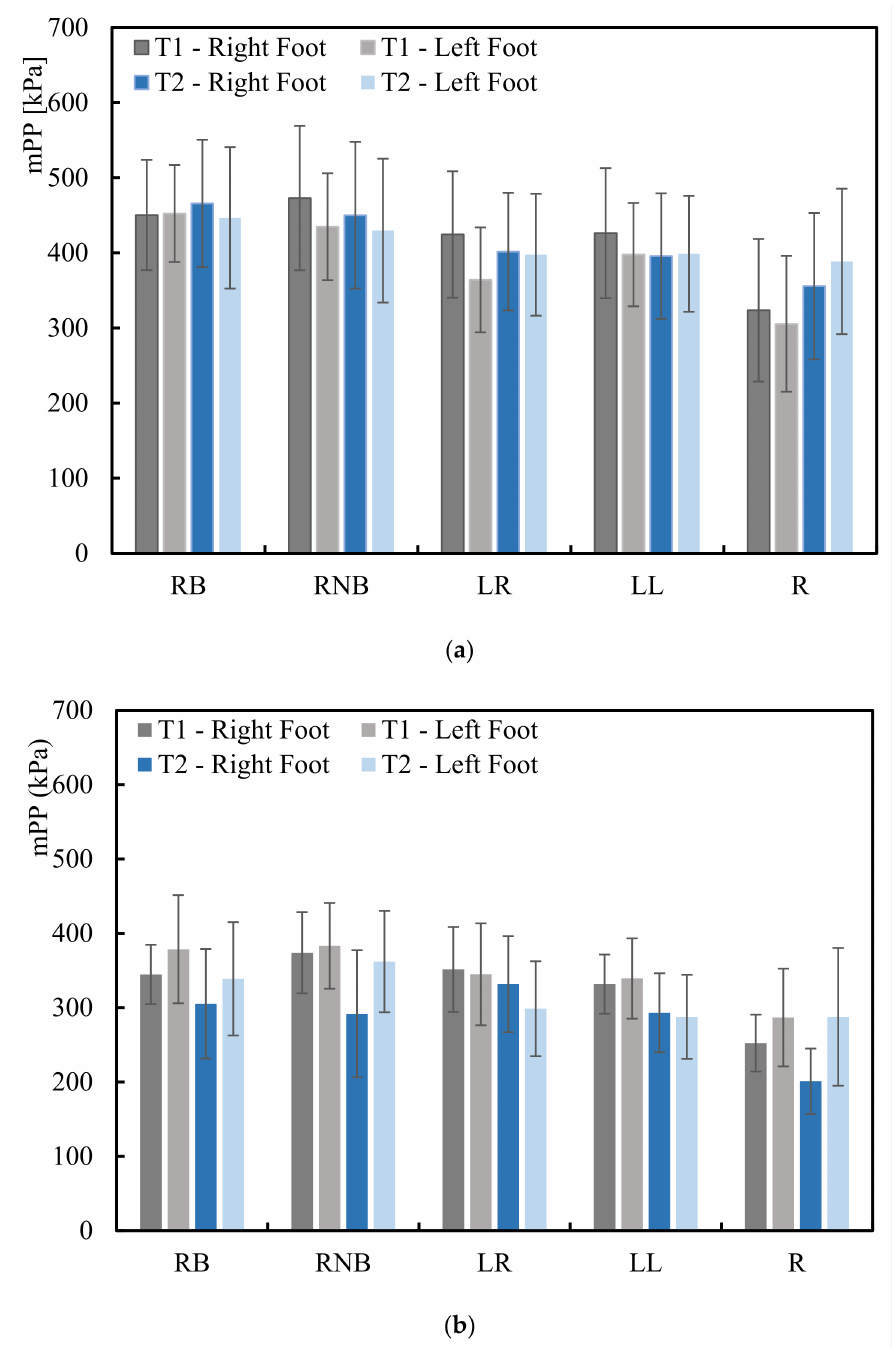
Figure 5. Mean peak pressure (mPP): ( a ) Level 1; ( b ) Level 2. RB—running with the ball; RNB—running without the ball; LR—lay-up on the right side; LL—lay-up on the left side;